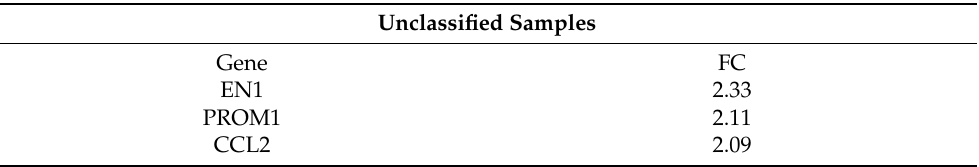
Table 4. Upregulated DEGs of unclassified